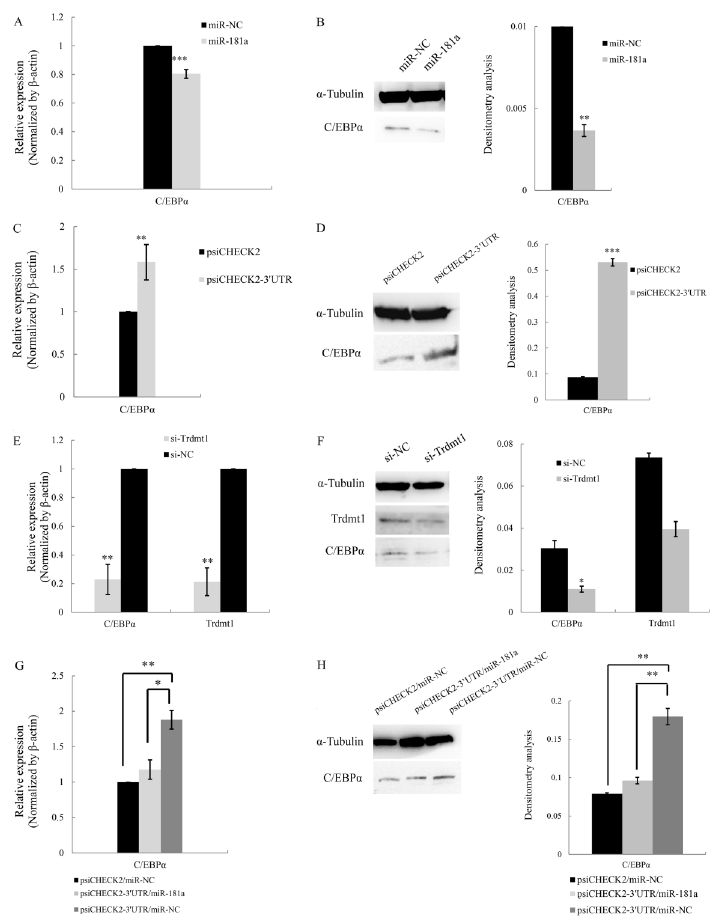
Figure 5. Regulation of C/EBP a by Trdmt. A , qPCR analysis of C/EBP a mRNA in HL-60 cells transfected with miR-181 mimic and mimic control. B , Western blot analysis and corresponding densitometry analysis of C/EBP a protein in HL-60 cells transfected with miR-181a mimic or mimic control. C , qPCR analysis of C/EBP a in HL-60 cells transfected with Trdmt1 3 0 untranslated region (UTR) (psiCHECK2- 3 0 UTR) and control (psiCHECK2). D , Western blot analysis and corresponding densitometry analysis of C/EBP a protein in HL-60 cells treated as described in panel C. E , qPCR analysis of C/EBP a and Trdmt1 mRNA in HL-60 cells transfected with Trdmt1 siRNAs (si-Trdmt1) and control (si-control). F , Western blot analysis and corresponding densitometry analysis of C/EBP a and Trdmt1 protein in HL-60 cells treated as described in panel E. G , qPCR analysis of C/EBP a mRNA in HL-60 cells transfected with control, Trdmt1-3 0 UTR, or Trdmt1-3 0 UTR plus miR-181a mimic. H , Western blot analysis and corresponding densitometry analysis of C/EBP a protein in HL-60 cells treated as described in panel G. Data are reported as means ± SD. *P o 0.05; **P o 0.01; ***P o 0.001 (ANOVA or Student ’ s t